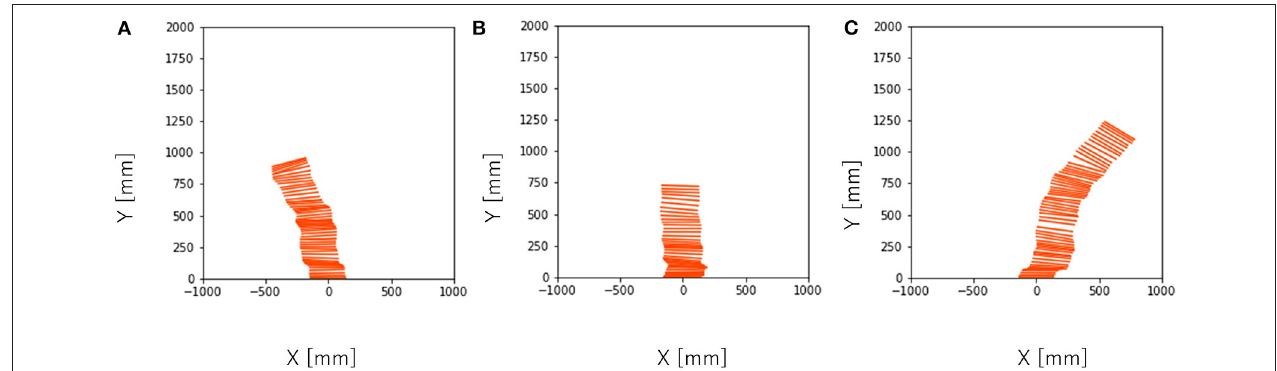
FIGURE 7 | Turning behavior captured by the camera near the ceiling every 1/30 s with T = 300. (A) T φ = − 15, (B) T φ = 0, (C) T φ = 15.